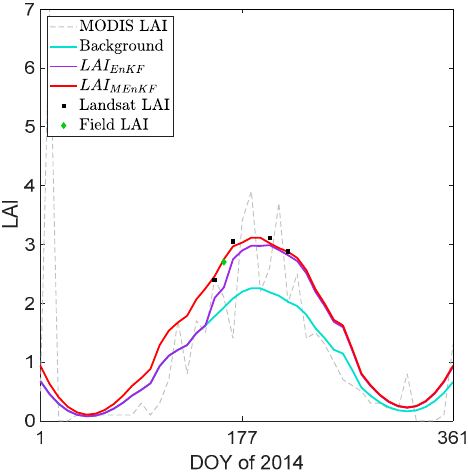
Figure 4. LAI time series generated by MEnKF for farmland.